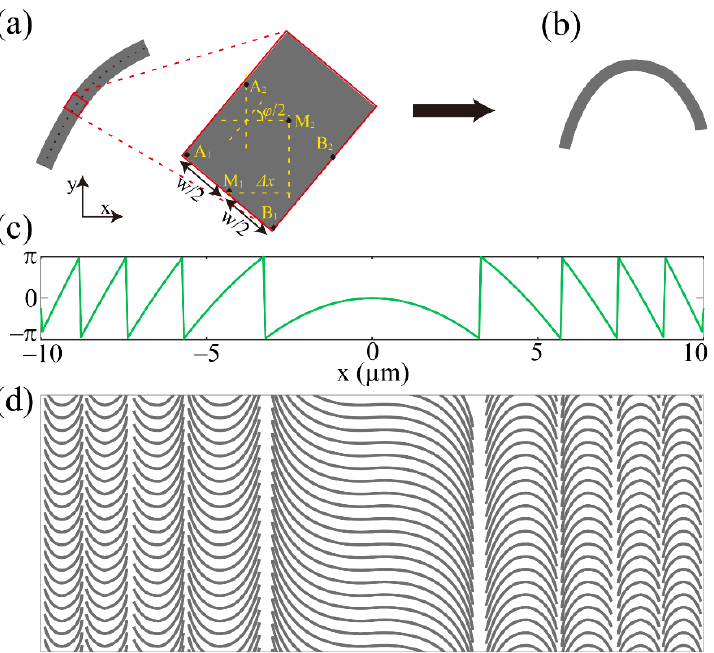
Figure 2. ( a , b ) Schematic diagram of the design process. ( c ) Ideal phase profiles of the QCMS. ( d ) Constructed QCMS with an area of 20 μm × 10 μm.